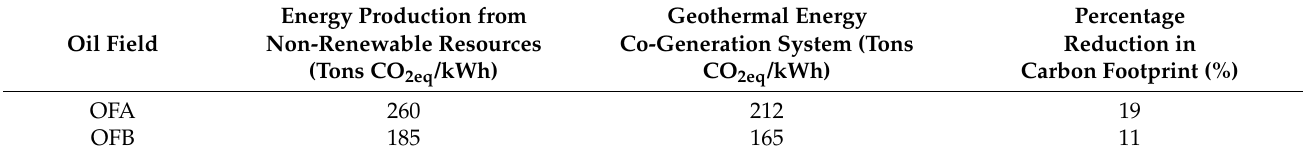
Table 6. Tons of CO 2 equivalent per kWh generated for the raw material inputs and energy genera- tion phases.